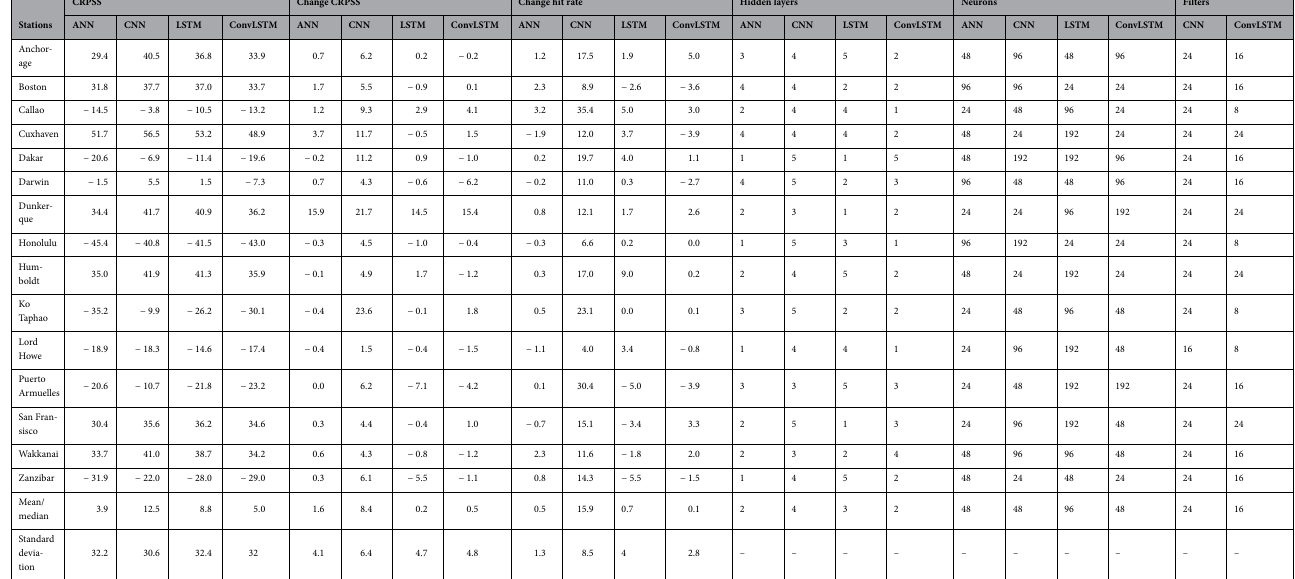
Table 1. Results of the NN architecture hyperparameter optimization. The change in hit rate is expressed in percentages increase of model ensemble ability to capture observed value within the ensemble spread. The summary statistics shown are mean for CRPSS, change in CRPSS and change in hit rate, and the median for the